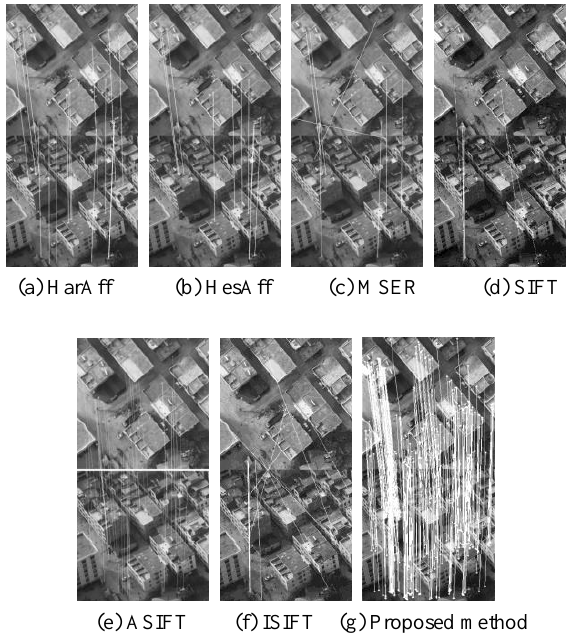
Figure 10. Matching results based on Dataset